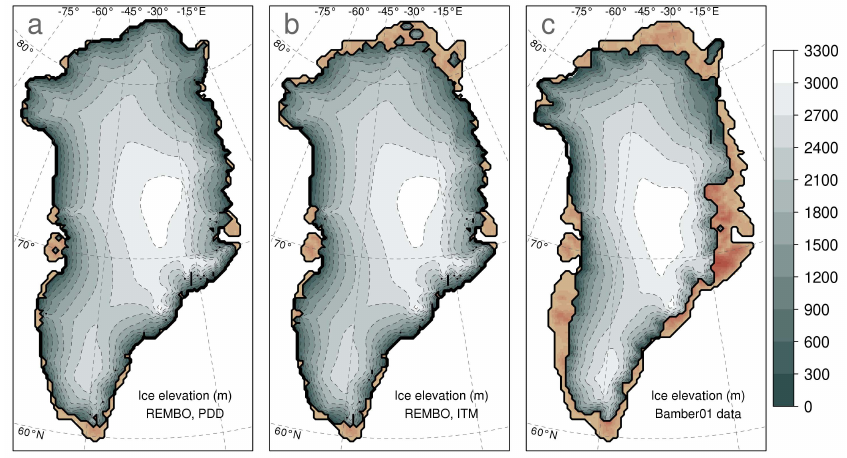
Fig. 9. Equilibrium simulated GIS elevations using REMBO with (a) PDD ablation and (b) ITM ablation, compared with (c) the actual GIS elevation from observations.